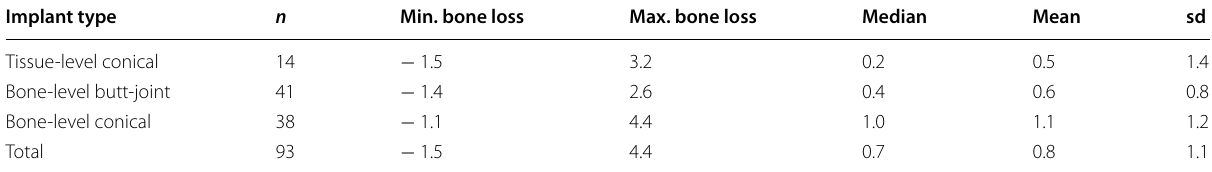
Presentation of minimal/maximal bone loss values during the study (10 to 20 years) according to implant type sd standard deviation